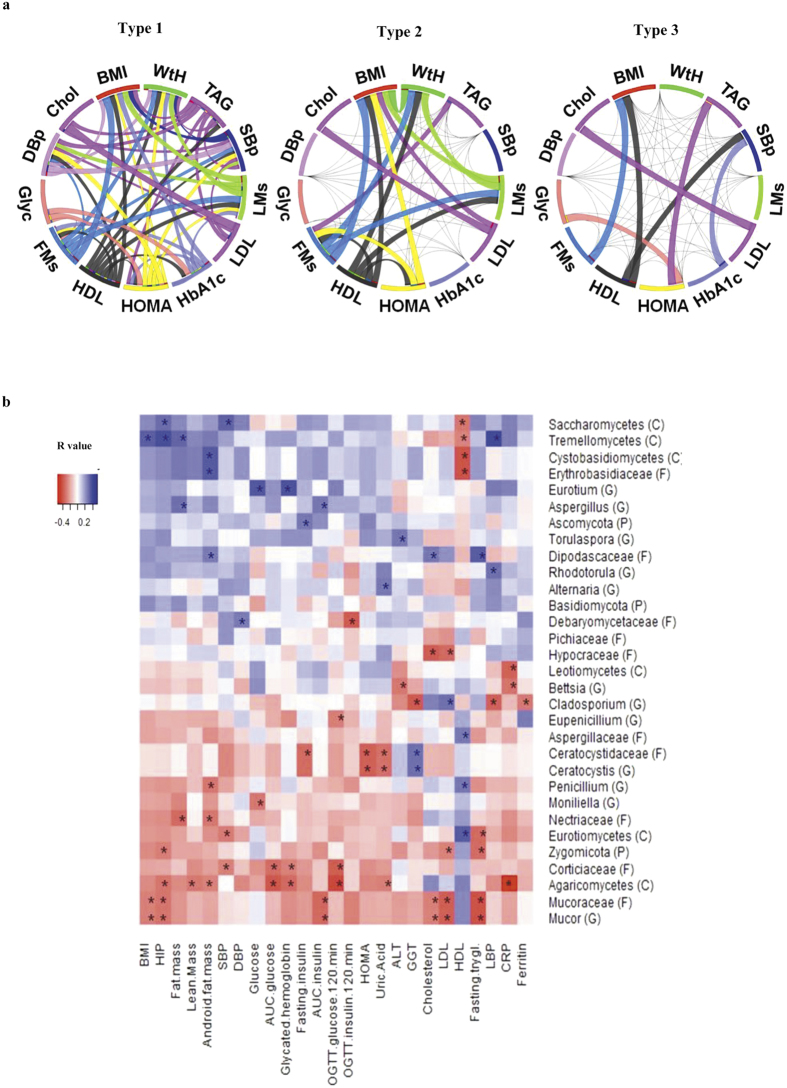
Relationships between human mycobiome and anthropometric and metabolic parameters.(a) Circos table viewer plot of significant correlations (Spearman test, at least p < 0.05) among anthropometric, metabolic and cardiovascular parameters in the identified clusters. The different Circos graphs depict that these associations are present in individuals belonging to specific clusters while in others the correlation disappears. Black color indicates negative correlations and edge width of lines connecting segments is proportional to correlation coefficient (b) Heat map showing associations of phylum, class, family and genus with clinical and anthropometrical data. The heat map is organized with fungi in rows and metabolic parameters in columns. *p < 0.05. Abbreviations key: P: Phylum, F: Family, C: Class, G: Genus, BMI: Body mass index, SBp: Systolic blood pressure, DBp: Diastolic blood pressure, LMs: Lean mass, FMs: Fat mass, WtH: waist to hip ratio, TAG: triacylglycerides, Glyc: fasting glycemia, Chol: total cholesterol, GTT: Glucose tolerance test, AUC: Area under the curve, HOMA: homeostatic model assessment insulin resistance, AST: Aspartate aminotransferase, ALT: Alanine aminotransferase, GGT: Gamma-glutamyltranferase, LDL-cholesterol: low-density lipoprotein, HDL-cholesterol: high-density lipoprotein, LBP: Lipopolysaccharide-binding protein, CRP: C-reactive protein.